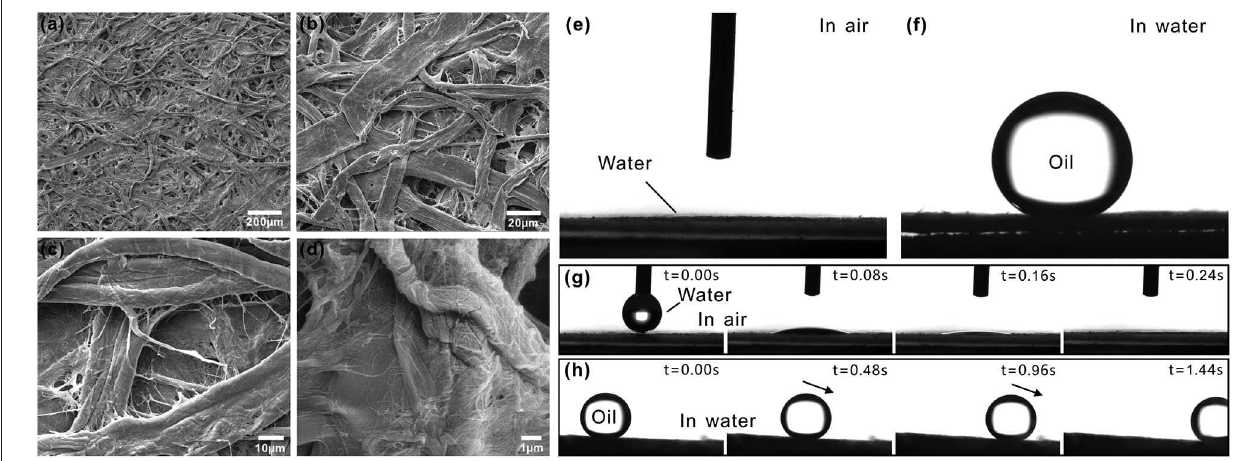
FIGURE 1 | Surface morphology and wettability of a filter paper. (a–d) SEM images of the filter paper. (e) Water droplet on the filter paper in air. (f) Oil droplet on the filter paper in water. (g) Process of a small water droplet being absorbed by a filter paper. (h) Underwater oil droplet rolling on a filter paper.